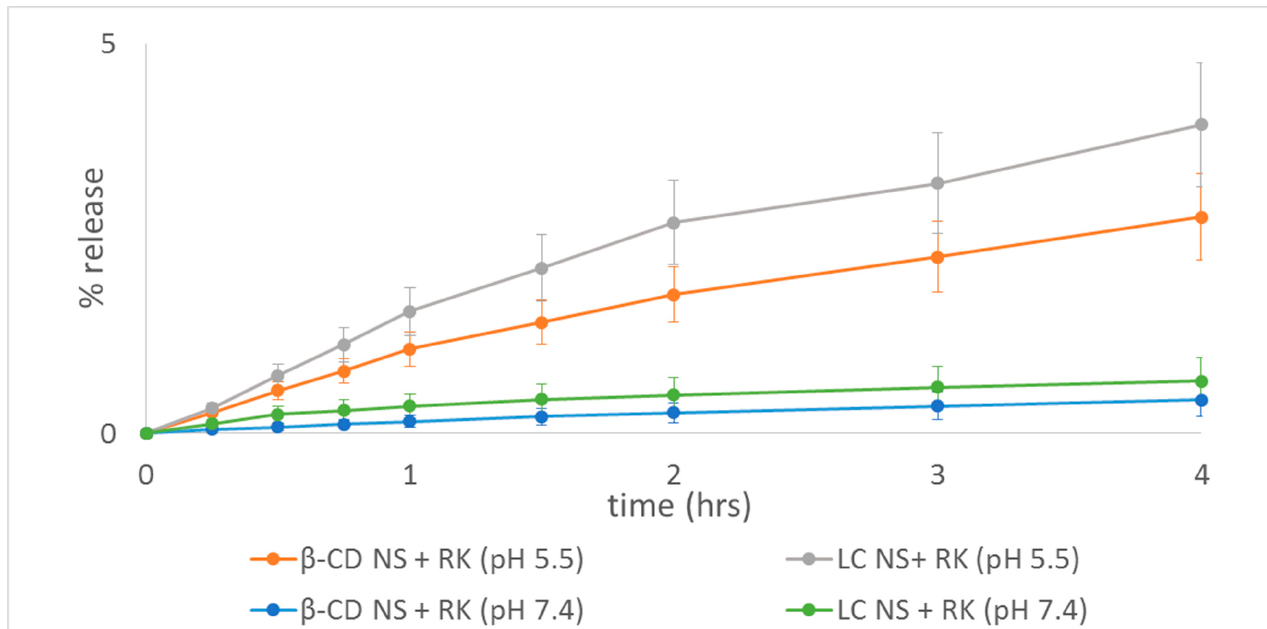
Figure 8. In vitro release profiles of RK-loaded NSs in pH 5.5–7.4 the first 4 h.